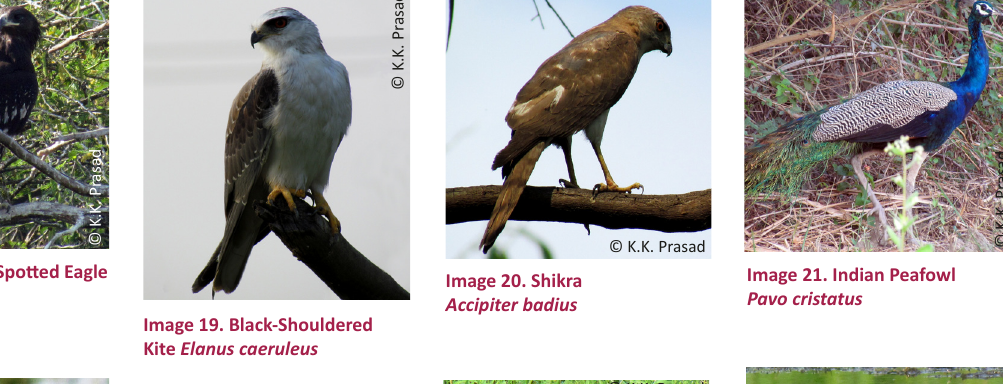
Image 20. Shikra Accipiter badius